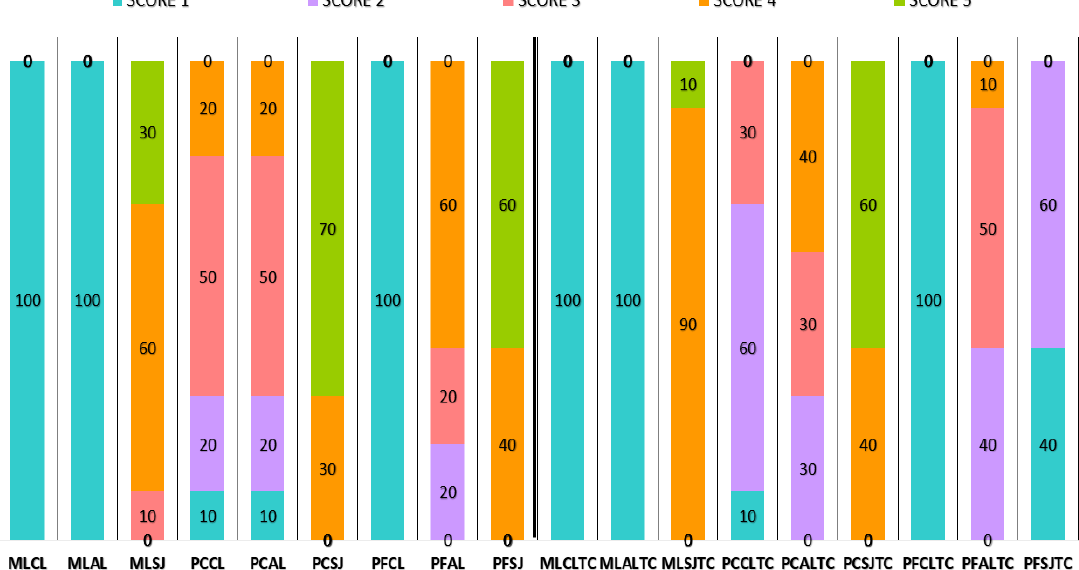
Figure 5. Failure mode percentage distribution for each material, surface treatment and storage condition (before and after thermal-cycling/TC).